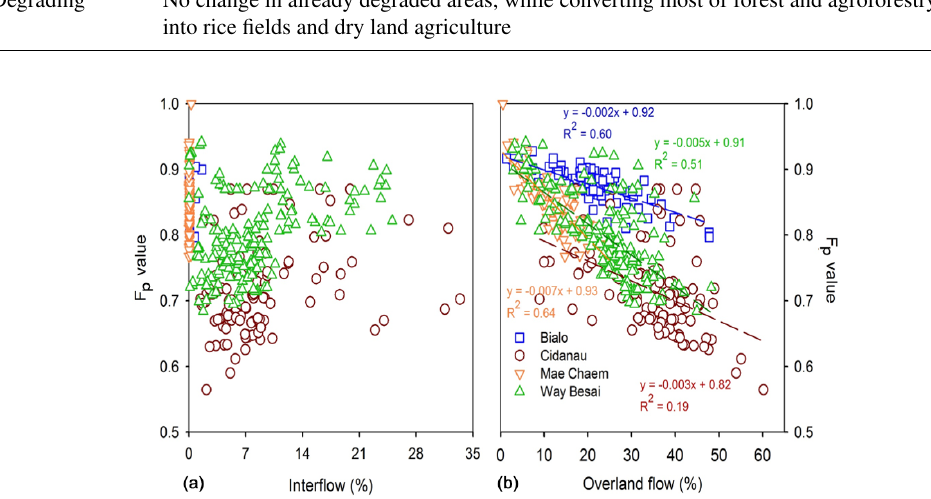
Figure 7. Correlations of F p with fractions of rainfall that take overland flow and interflow pathways through the watershed, across all years and land use scenarios of Fig.